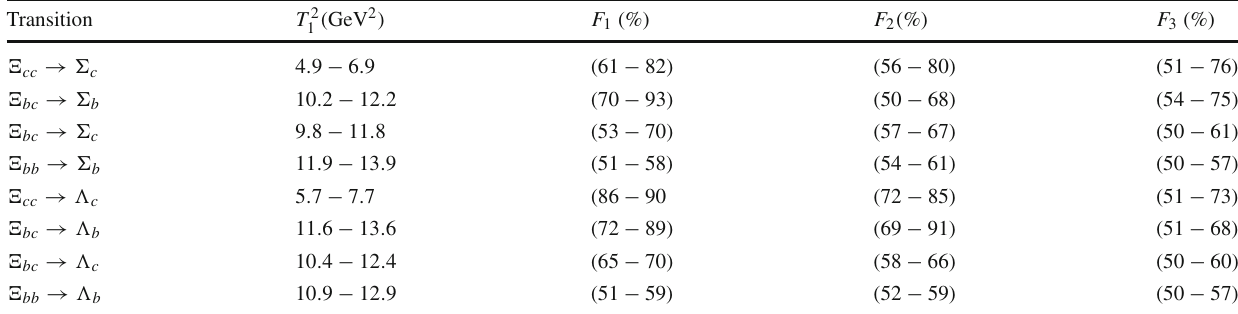
and the range of r in by Eq. (35). The momentum transfer squared q 2 is taken at − 0 . 5 GeV 1 is determined 2